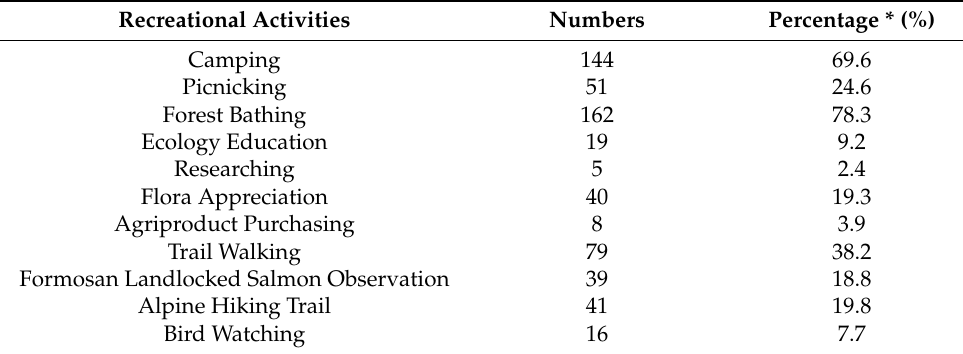
Table 5. Tally and ratio of preferred tourist